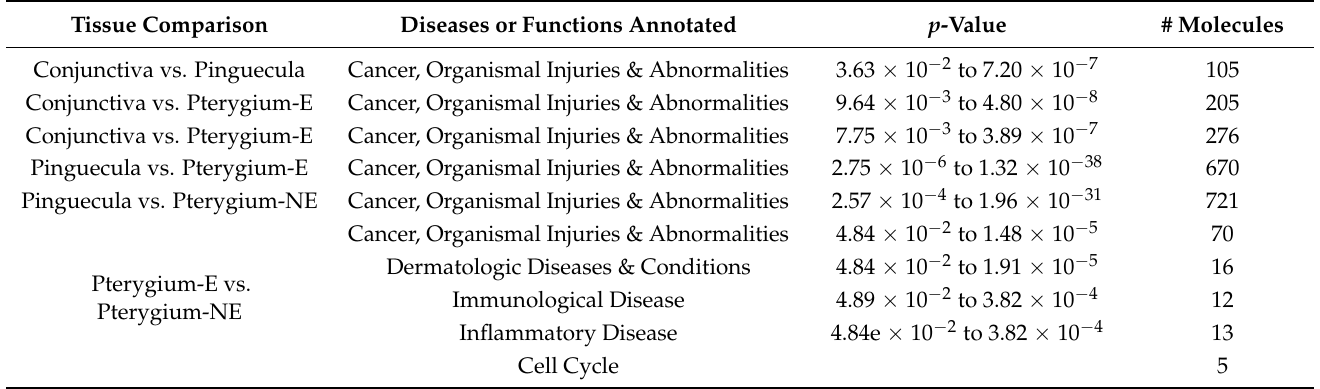
Table 4. IPA Top Diseases and Biological